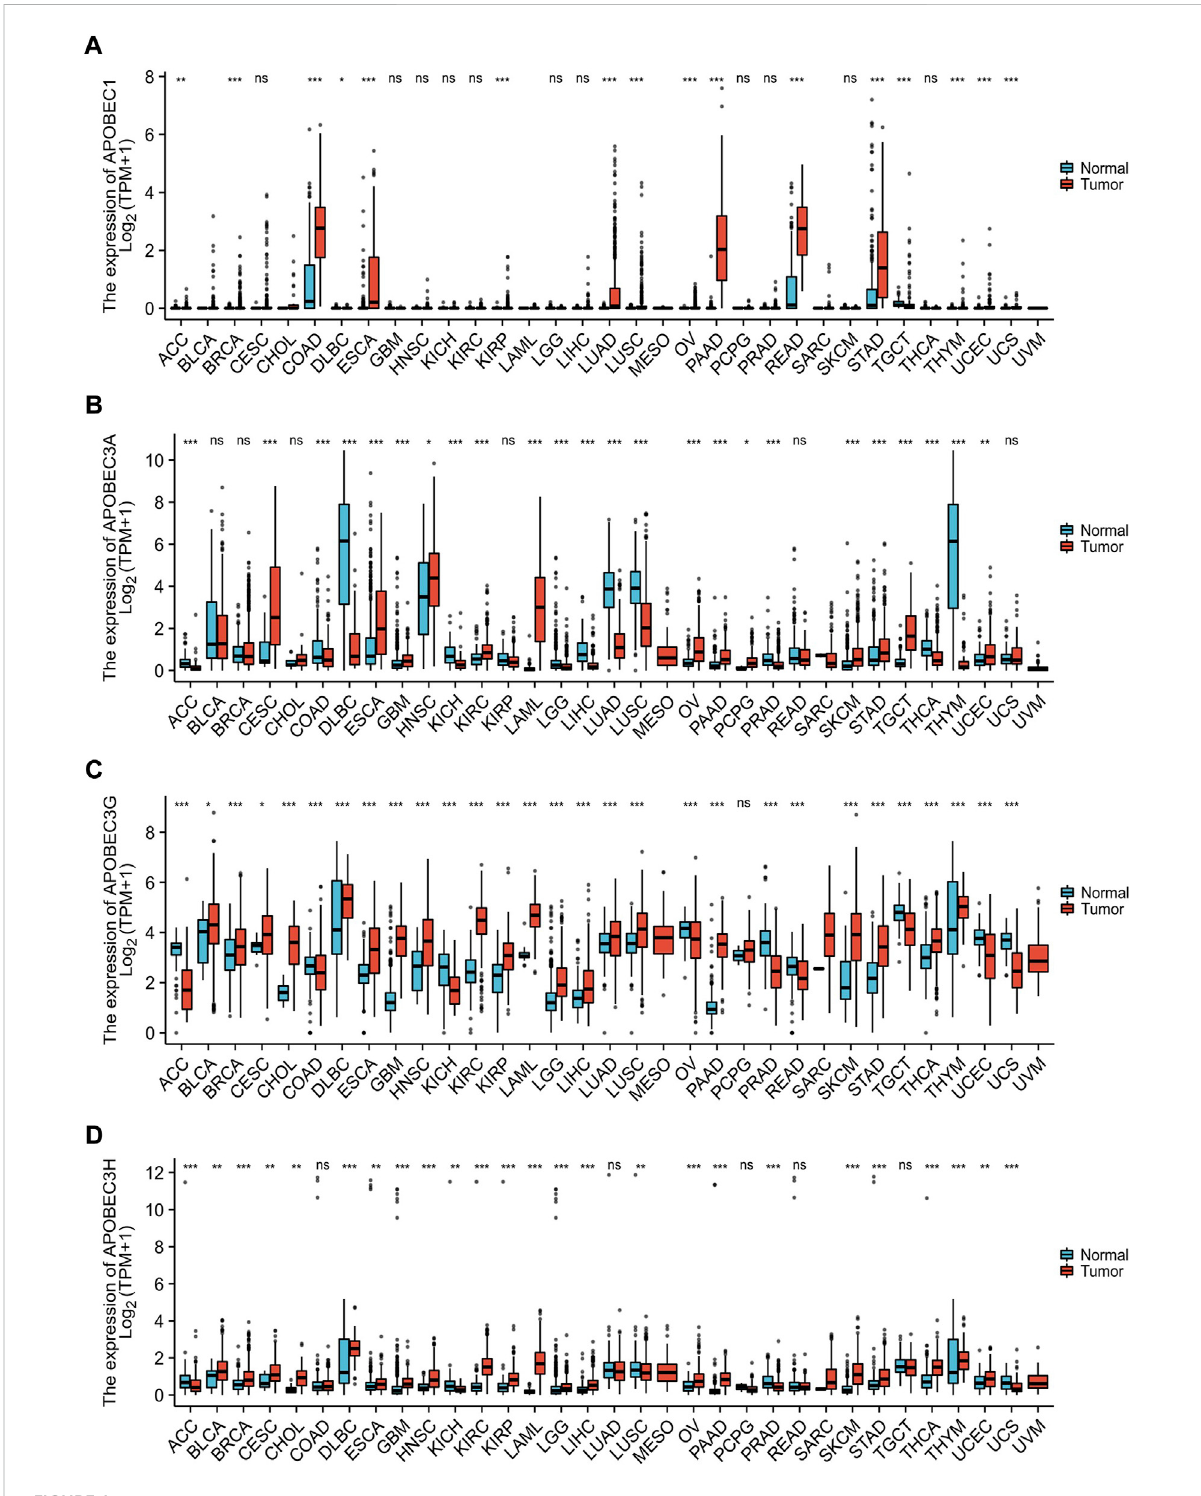
FIGURE 1 Expression analysis of the APOBEC family members APOBEC1, APOBEC3A, APOBEC3G and APOBEC3H across cancers. (A) The expression level of APOBEC1; (B) The expression level of APOBEC3A; (C) The expression level of APOBEC3G; (D) The expression level of APOBEC3H. ns, p ≥ 0.05; *, p < 0.05; **, p < 0.01; ***, p <